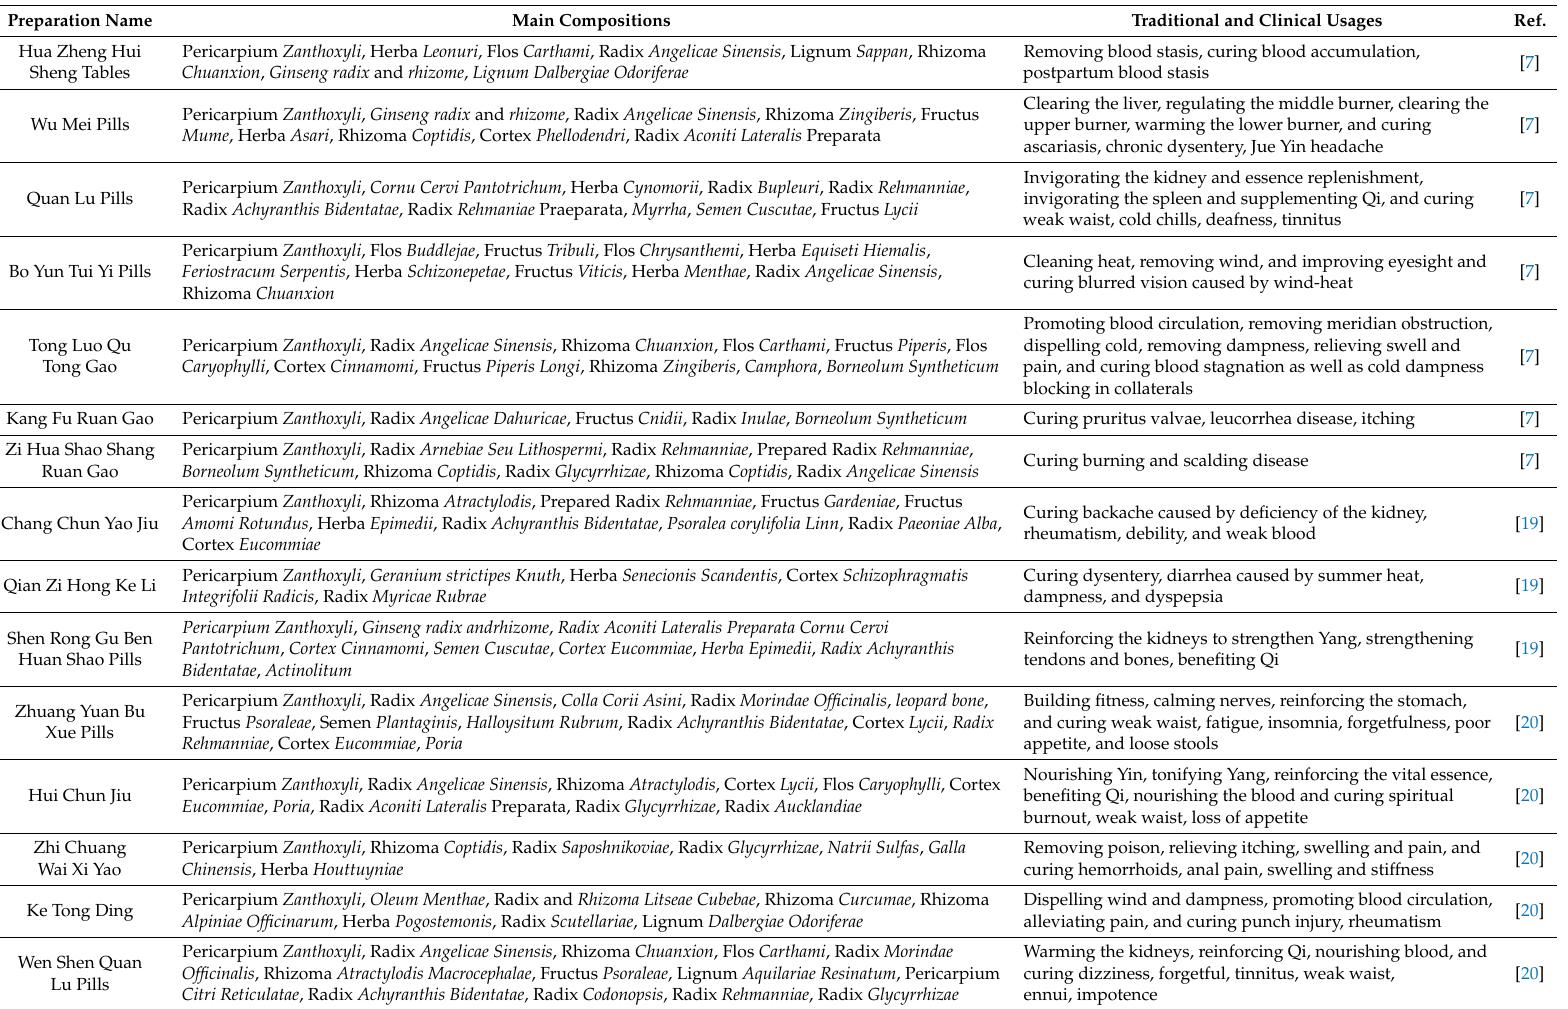
Table 1. The traditional and clinical use of Z. bungeanum in